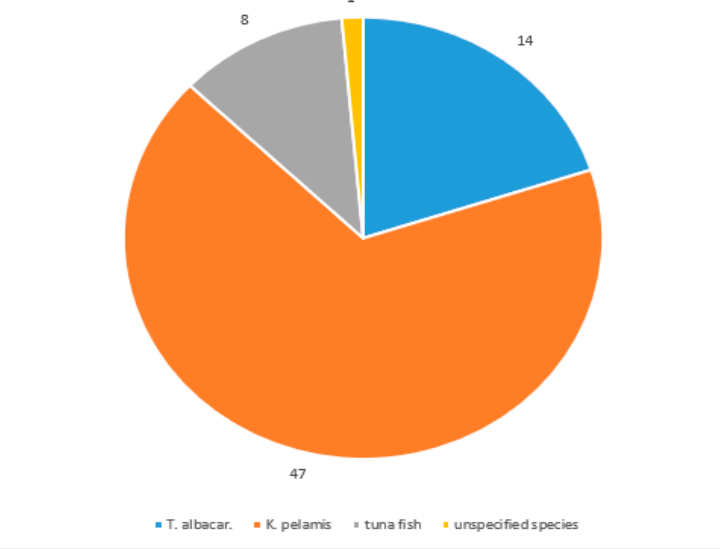
Figure 4. Declaration on the product label.